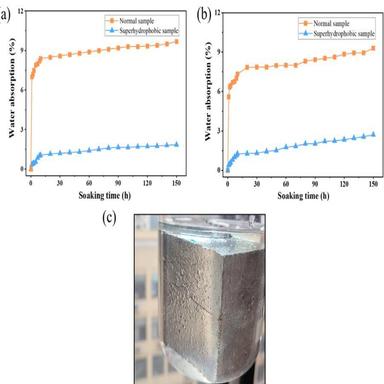
Water absorption test and superhydrophobic sample immersion test. (a) Water absorption of samples in deionized water, (b) water absorption of samples in 3.5 wt% NaCl solution and (c) highly reflective air-film on the surface of superhydrophobic concrete.